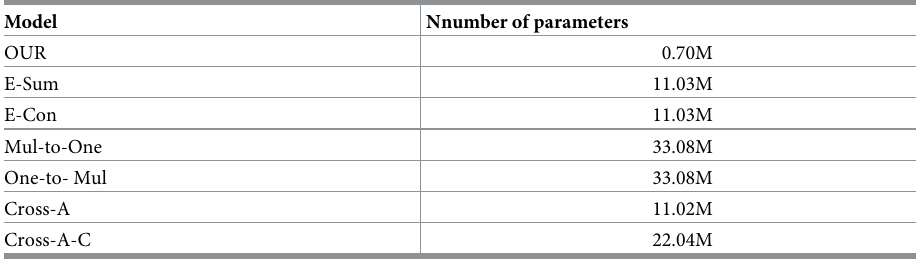
Table 5. Comparative results of ablation experiments on the Weibo dataset